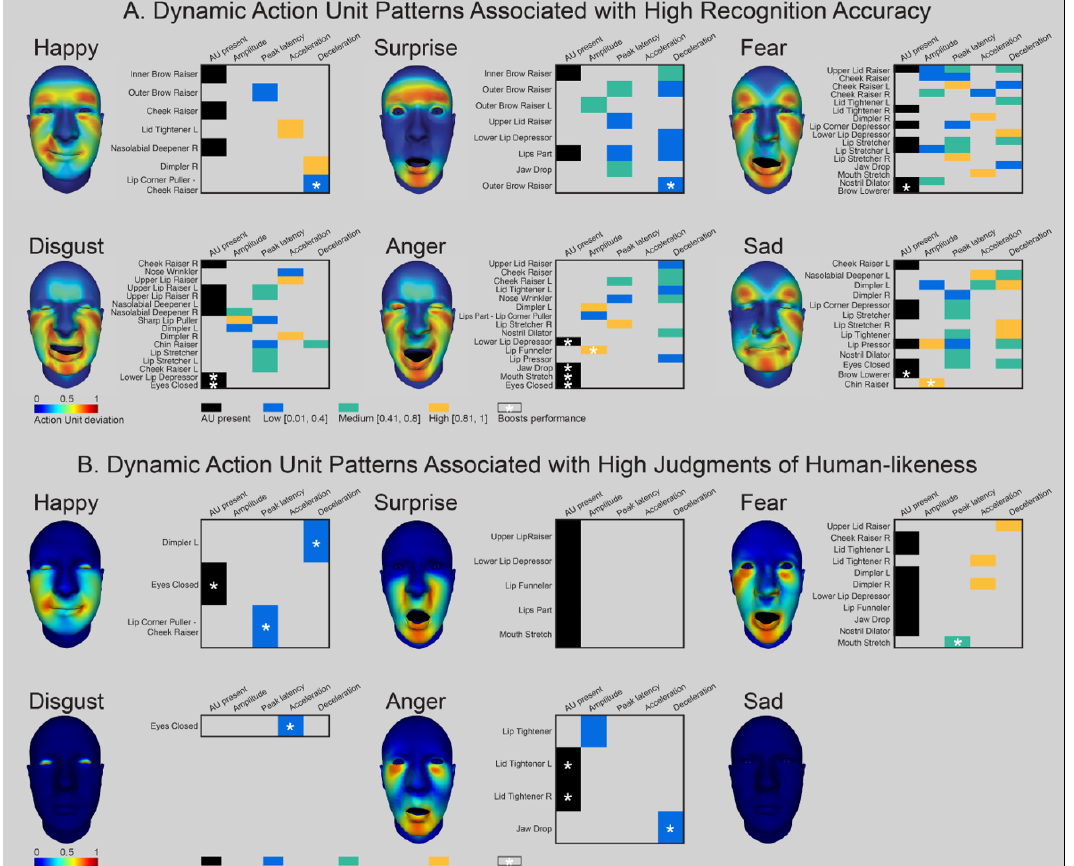
Figure 4. The culturally-sensitive dynamic action units that are associated with high recognition accuracy in panel ( A ) and high judgments of human-likeness in panel ( B ) (Reprinted with permission from C. Chen, et al. (2019). 2019 14th IEEE International Conference on Automatic Face & Gesture Recognition Name)